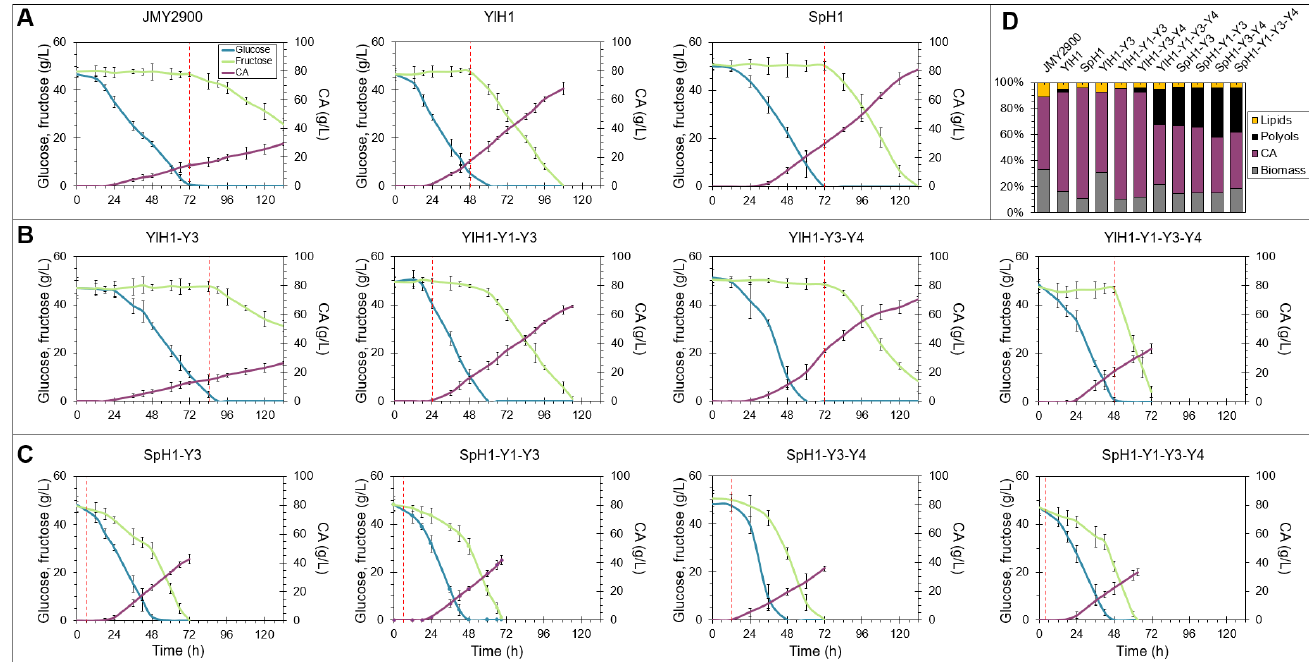
Figure 3. Sugar consumption and citric acid (CA) secretion of Y. lipolytica strains grown in a media optimized for citric acid production in 5 L stirred tank bioreactors ( A – C ); metabolic profiles of the analyzed strains ( D ). Red vertical dashed lines indicate the onset of fructose utilization. The cultivations were performed in three biological replicates. Table 1. Parameters of bioreactor cultures for citric acid production using Y. lipolytica transformants in defined medium with a mixture of glucose and fructose. The cultivations were carried out until complete depletion of the substrates or until 132 h (strains JMY2900, YlH1-Y3 and YlH1-Y3-Y4) and were performed in three biological replicates.